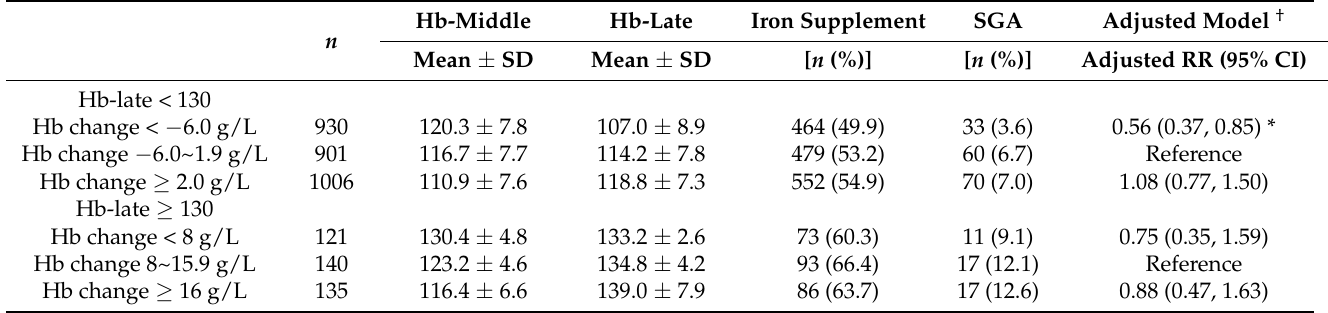
Table 4. Associations between Hb changes from the middle to late stages of pregnancy and